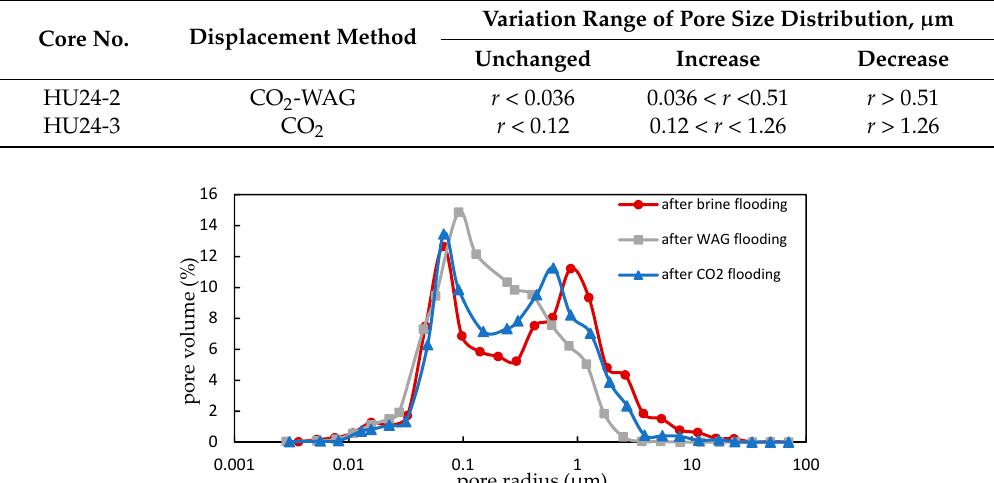
Table 7. Changes of pore size distribution in the cores HU24-2, HU24-3 after flooding. Core No.